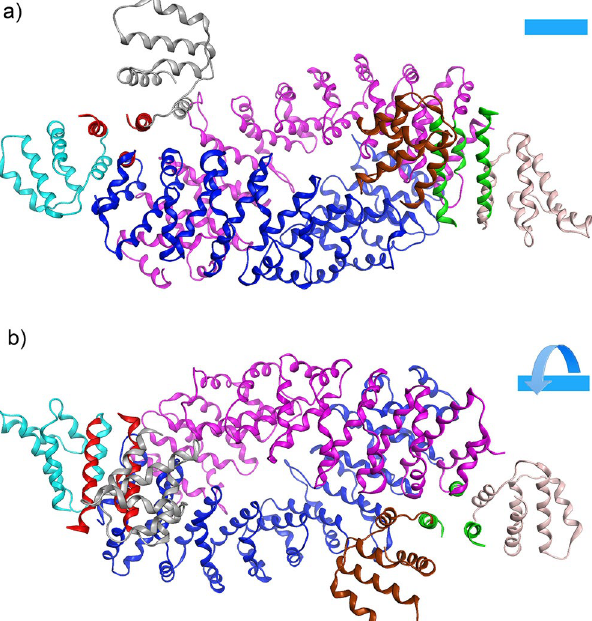
Figure 6. Molecular docking of the full LRRK2-FADD complex. ( a ) The dimeric model of LRRK2 ARM was used to dock two molecules of FADD DD on each end. By 180° rotation of the horizontal axis of the dimer interface ( b ), it is apparent that the axis of each group of triple-helix bundles is perpendicular to the other. Note that the established interacting α -helical bundles have been highlighted in red and green colored